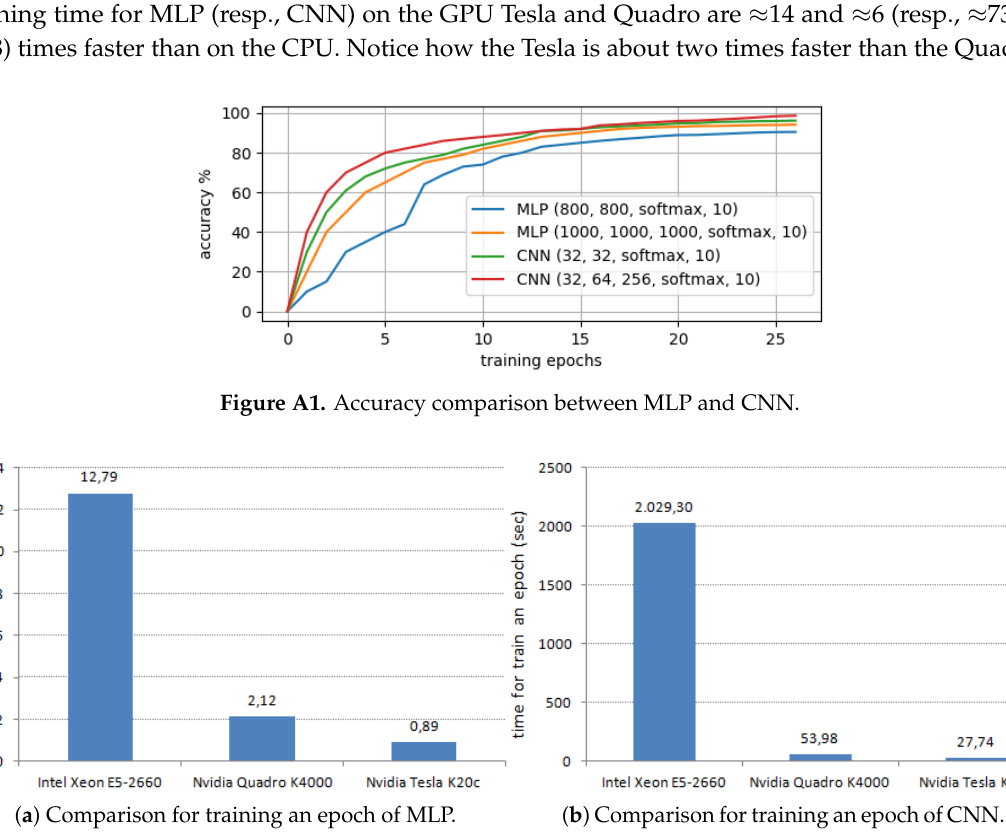
Figure A2. Performance evaluation of the two types of DNNs